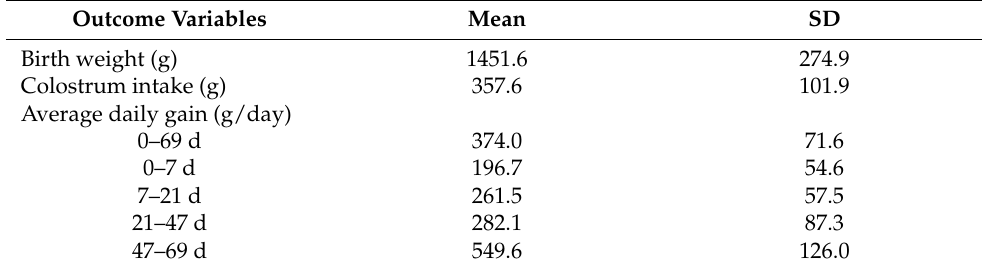
Table 1. Mean and standard deviation (SD) of the study outcome variables measured in piglets followed from birth until 69 days of